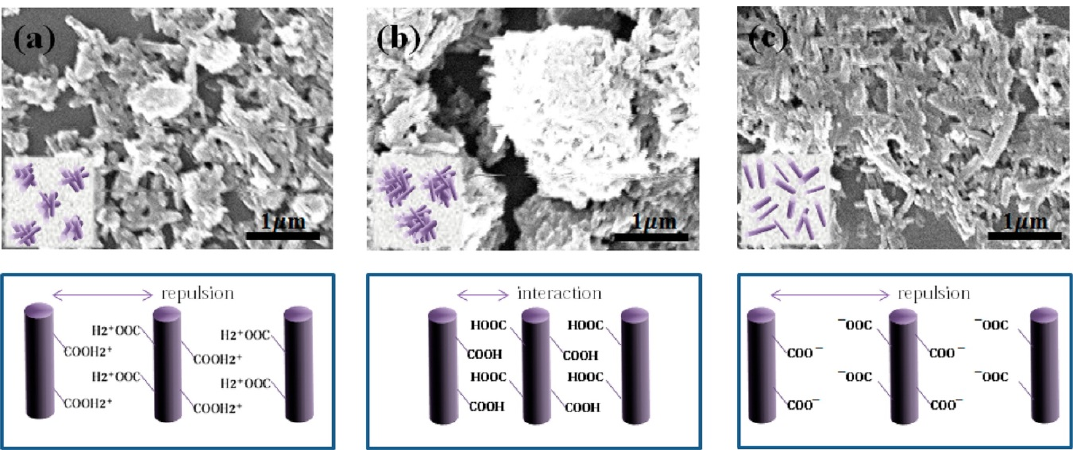
Figure 12. SEM images and a schematic illustration of HNTs-COOH in dry form from ( a ) acidic (pH 1), ( b ) neutral (pH 7), and ( c ) alkaline solution (pH 12). Reproduced with permission from [128].